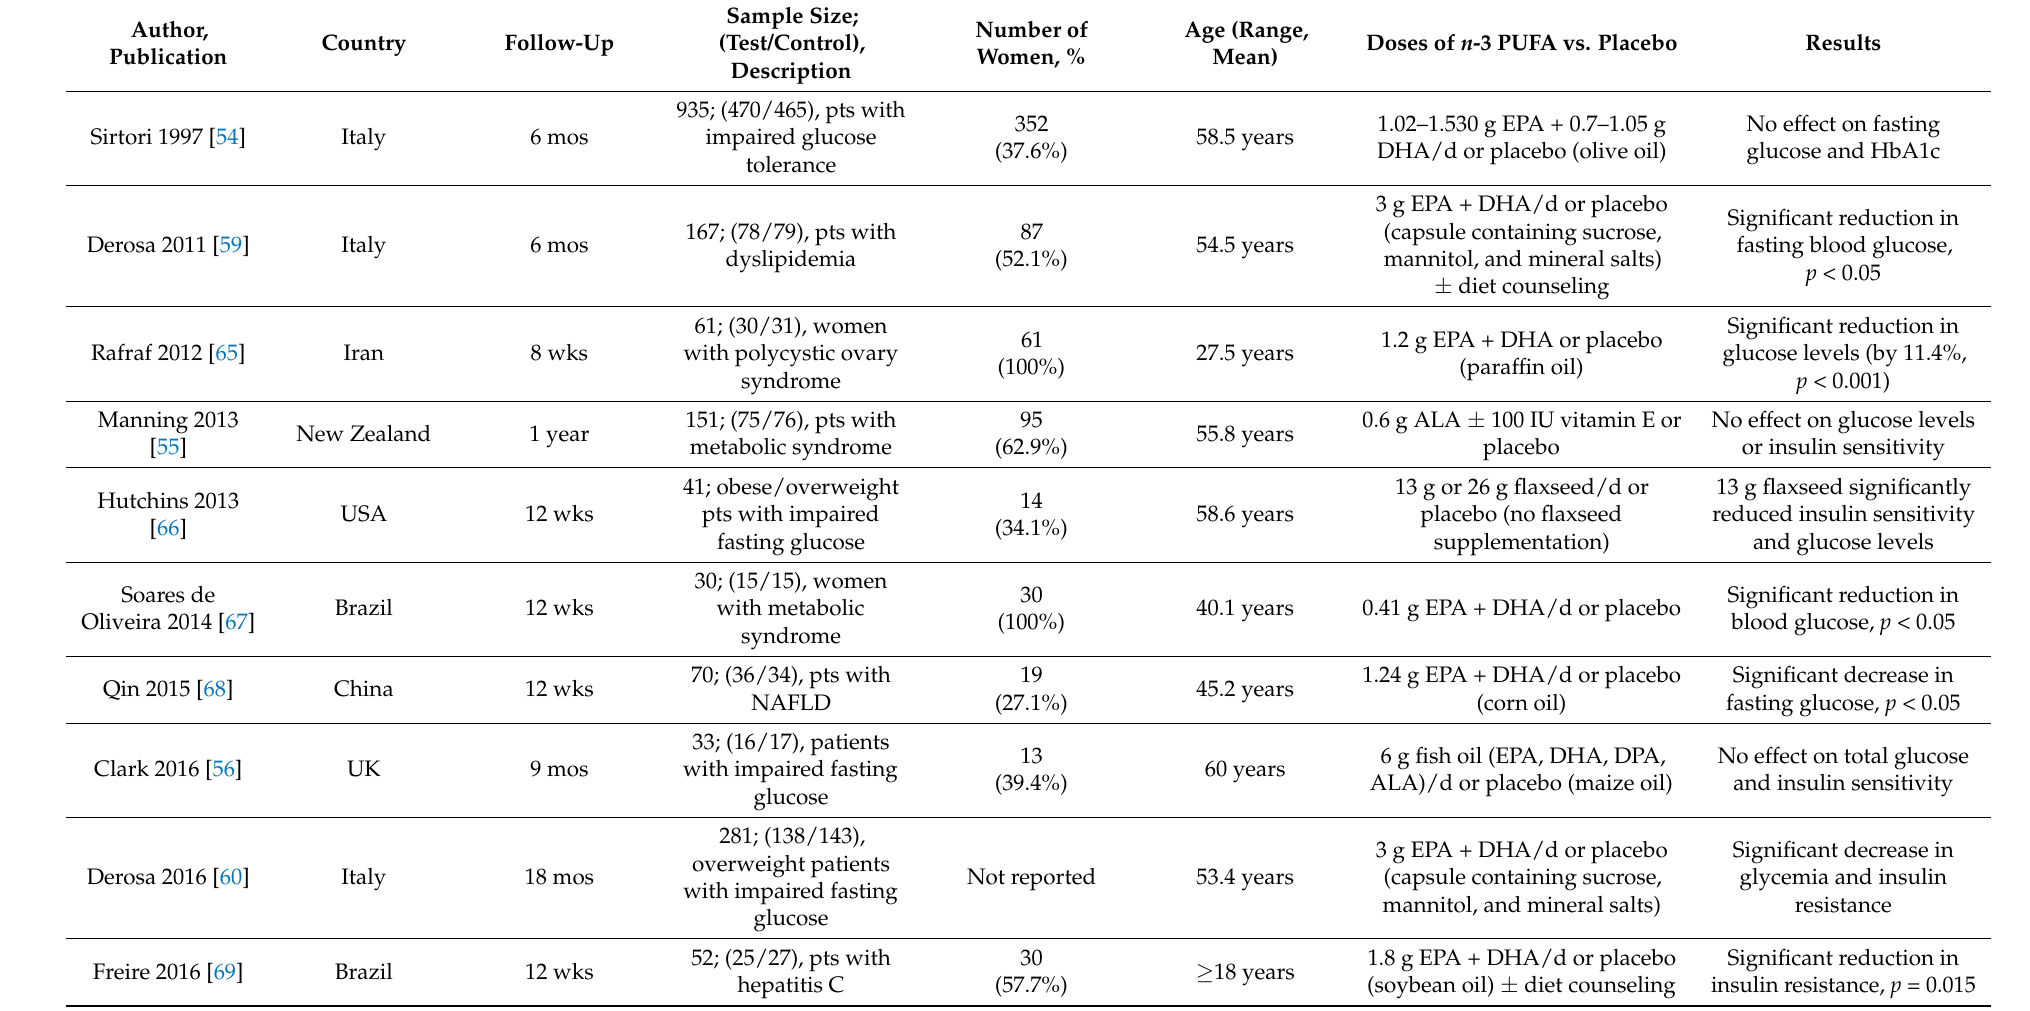
Table 3. Characteristics of RCTs studying the effects of n -3 PUFA on the parameters of type 2